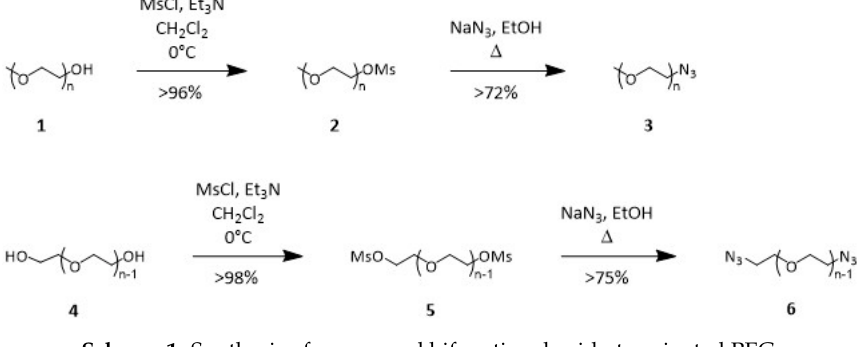
Table 1. Summary of functionalization efficiency and molecular characteristics obtained from 1 H NMR.